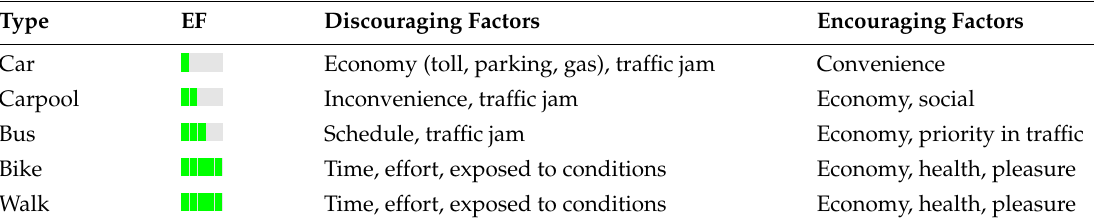
Table 1. Environmental friendliness (EF) and discouraging and encouraging factors for different types of transportation. Larger EF means environmentally friendlier type of transportation (from